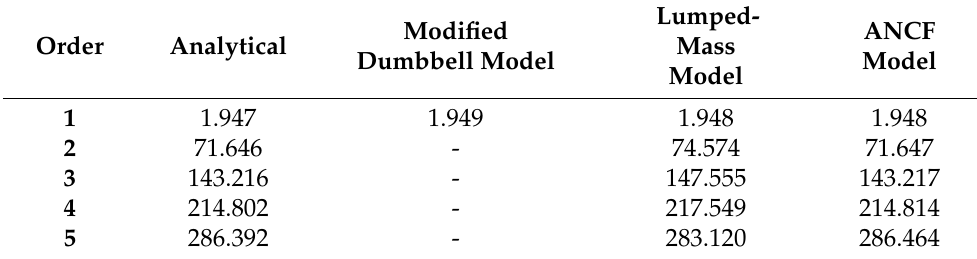
Table 5. Natural frequencies of the tethered system